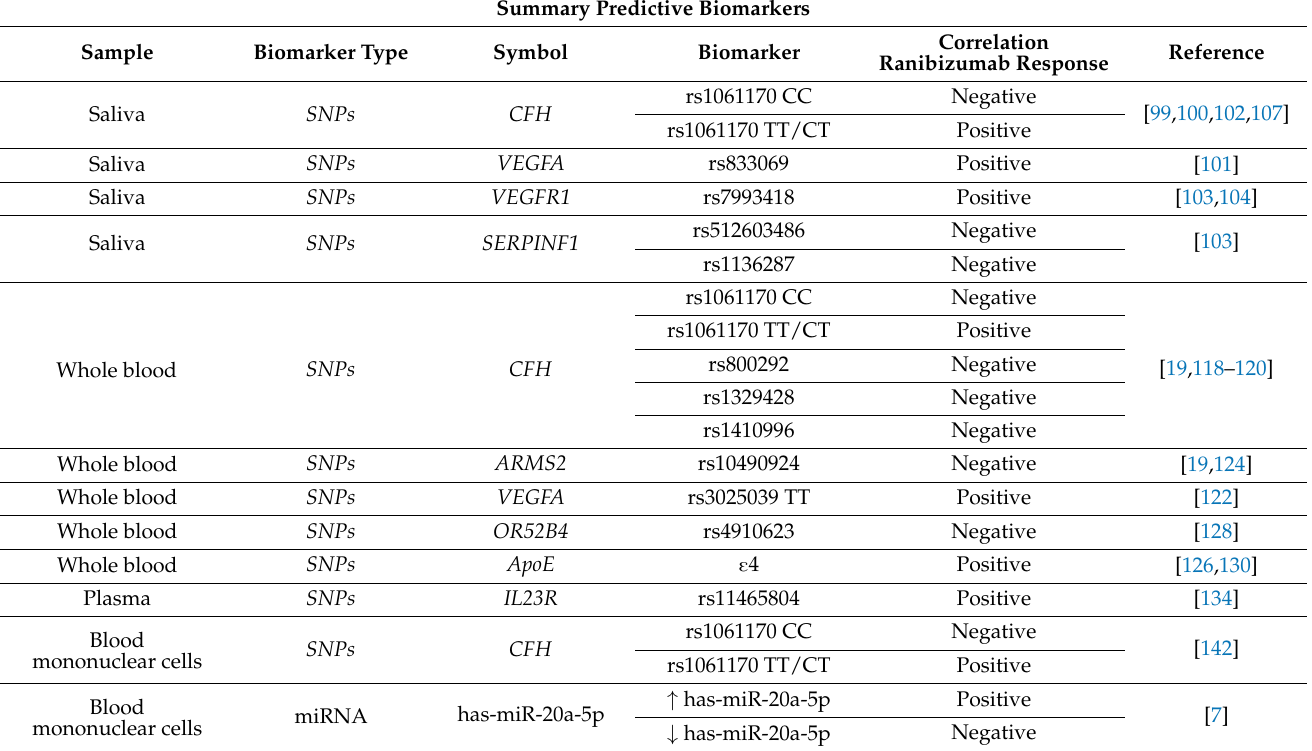
Table 2. Summary of the predictive